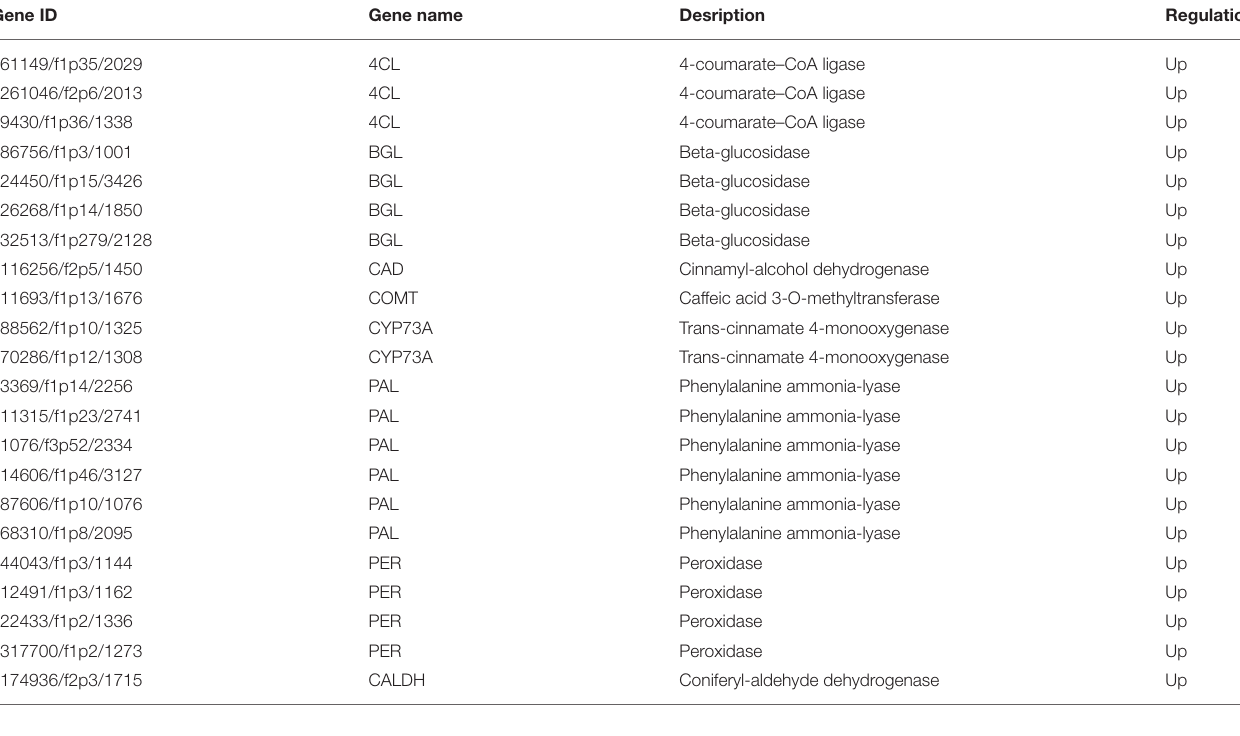
TABLE 1 | DEGs in the phenylpropanoid